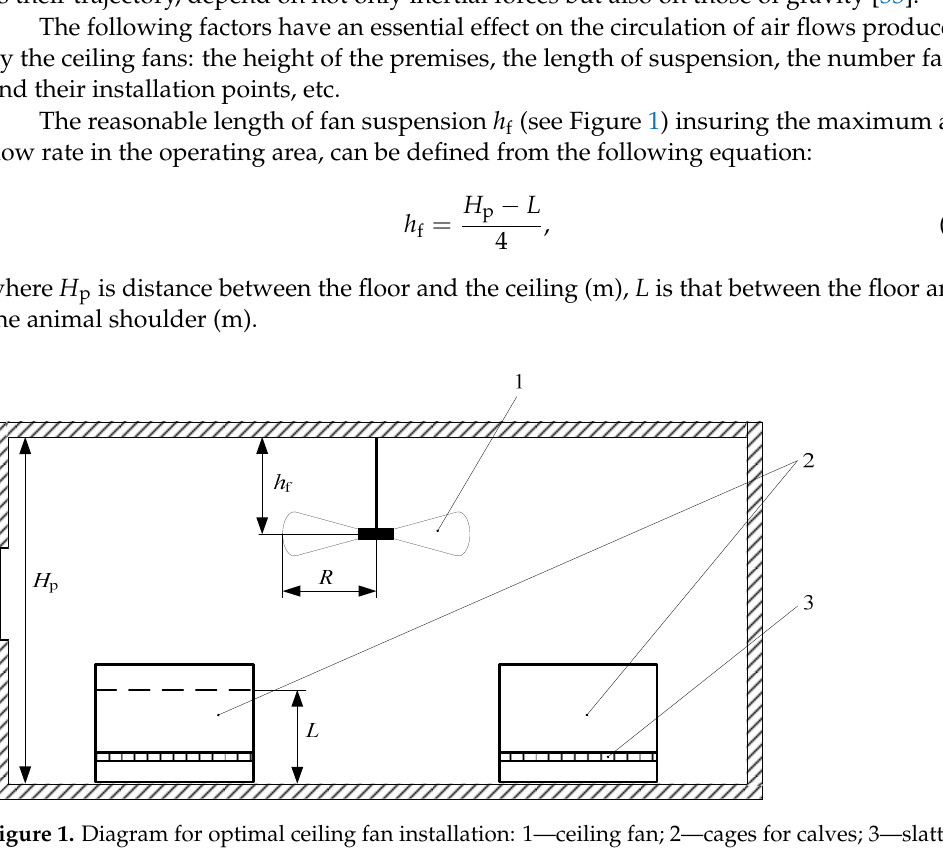
Figure 1. Diagram for optimal ceiling fan installation: 1—ceiling fan; 2—cages for calves; 3—slatted floor of the cage.